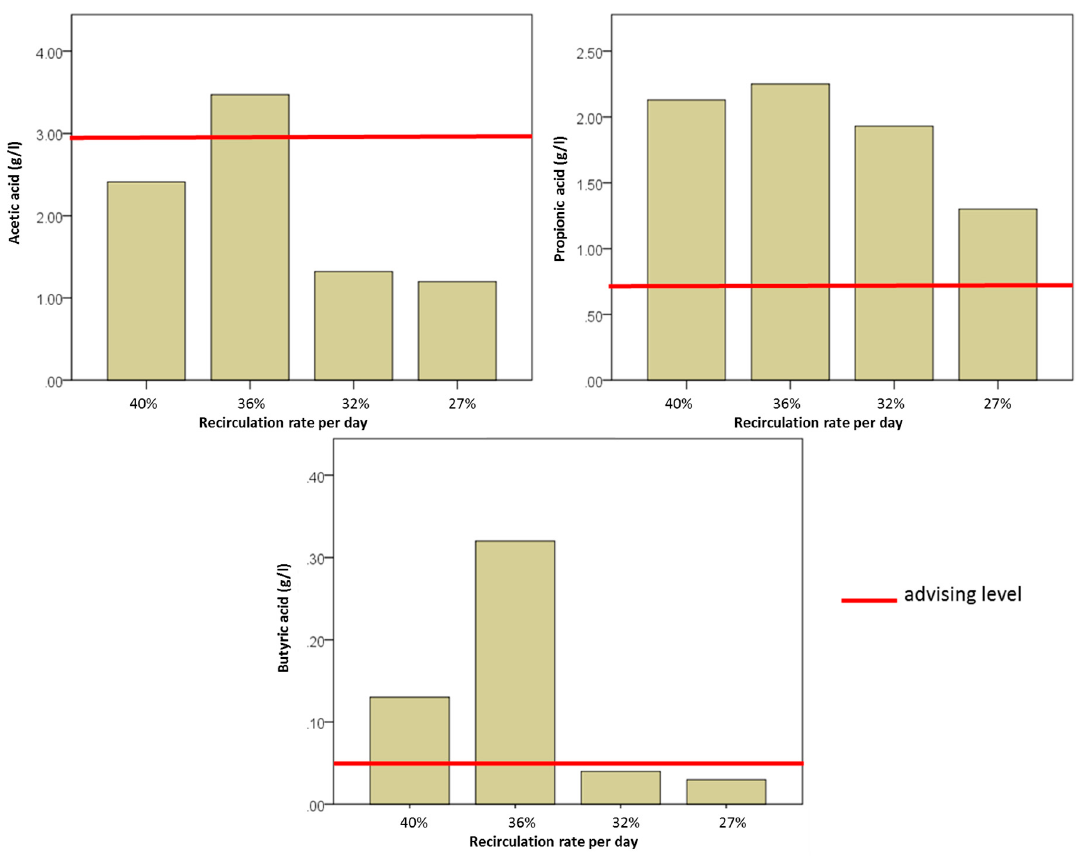
Figure 7. Acetic, propionic and butyric acid contents of the biogas substrate as a function of recirculation rate.